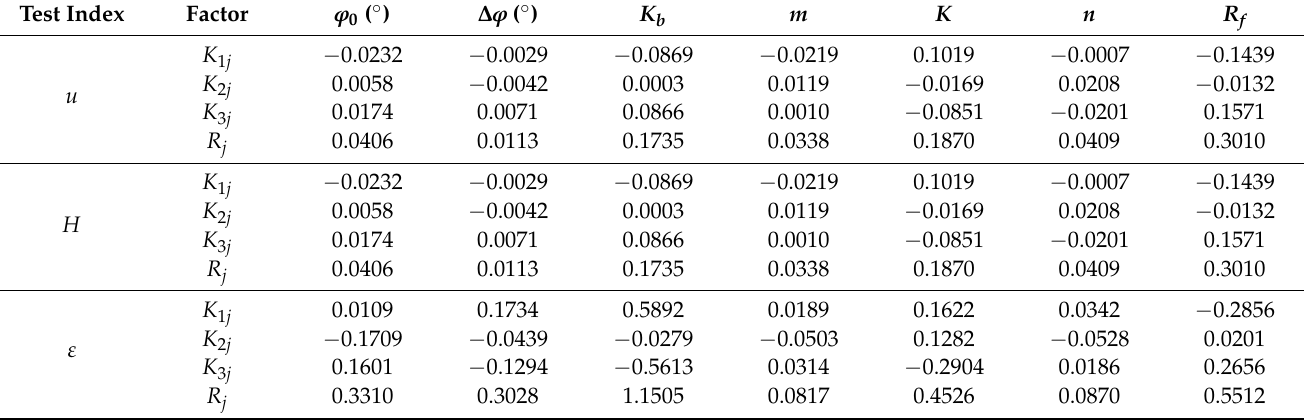
The range analysis method was used to process the results of each scheme in the three columns of u , H, and ε in the summary table of orthogonal test results in the reservoir bottom backfill zone (Table 7), and the range analysis results were shown in Table 10. Table 10. Range analysis results of influencing factors of each test index for the reservoir bottom backfill